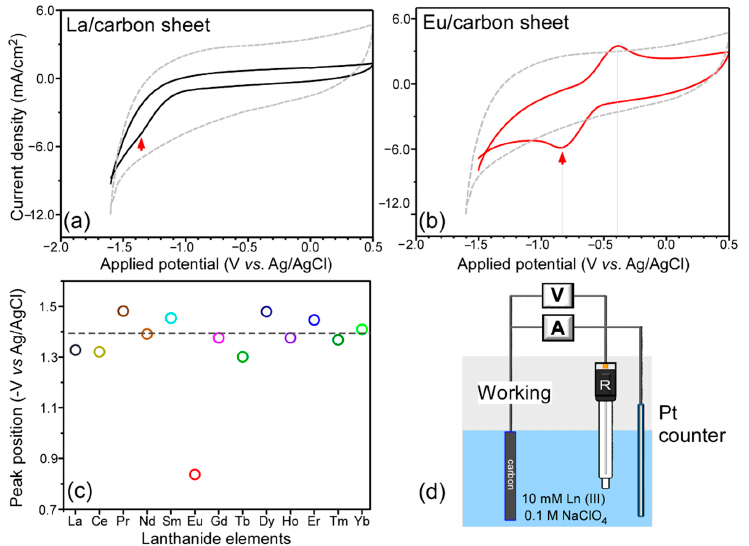
Figure 1. Cyclic voltammetry profiles for ( a ) 10 mM La(III) and ( b ) Eu(III) ions in 0.1 M NaClO 4 electrolyte on carbon sheets at a scan rate of 200 mV·s − 1 , ( c ) reduction peak positions with Ln elements, and ( d ) a schematic of a three-electrode system. Newly appeared curvature is indicated by a red arrow. Amperometry was performed at a fixed potential in 10 mM Ln(III)/0.1 M NaClO 4 electrolytes for 5 h to electrodeposit the Ln elements on carbon sheets. The surface mor- phologies of the electrodeposited Ln materials were fully examined by SEM, displayed in Figure 2. The SEM images (Figure 2B ‒ N) of all of the Ln-deposited samples were observed